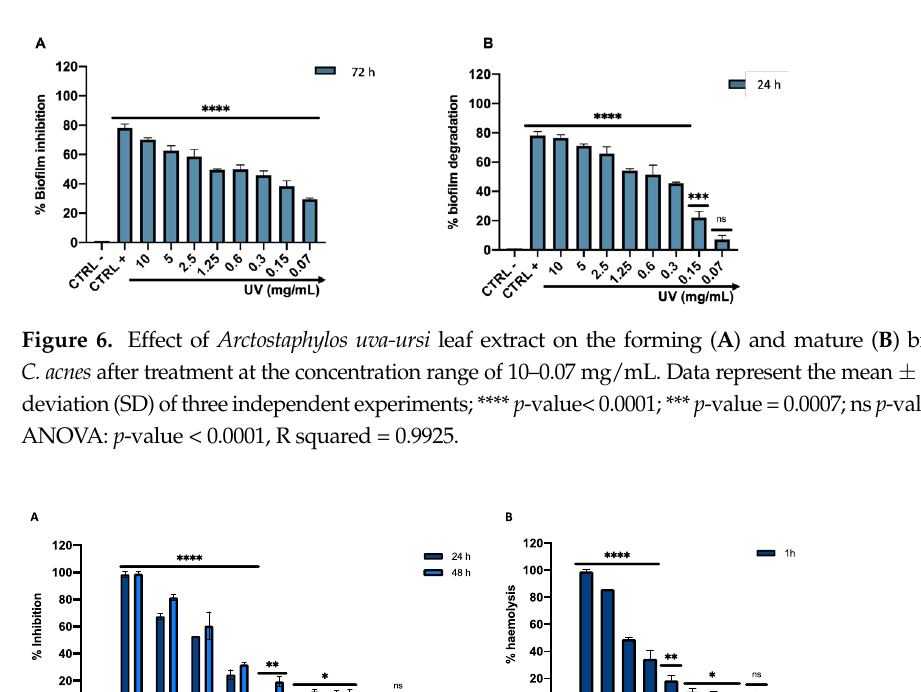
Figure 7. ( A ) HaCaT cytotoxicity after 24 and 48 h of treatment with Arctostaphylos uva-ursi leaf extract. ( B ) In vitro hemolysis assay after erythrocyte exposure to Arctostaphylos uva-ursi leaf extract. The data represent the mean ± SD. CTRL − : cells treated with the solvent used to dissolve the drug; CTRL+: DMSO used at toxic concentrations (100%) for MTT assay and TritonX 0.1% for hemolysis assay. Dunnett’s multiple comparisons test: **** p- value < 0.0001; ** p- value = 0.0061; * p- value = 0.0301; ns p- value > 0.05. Ordinary one-way ANOVA: p- value < 0.0001, R squared = 0.9984.